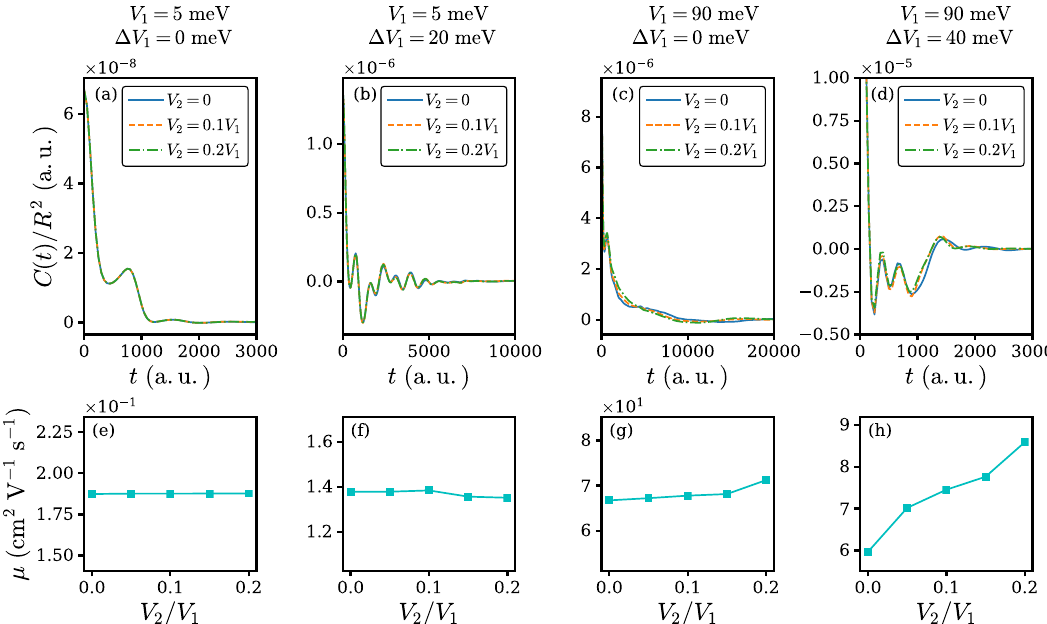
Fig. 6 The isotropy effect for several typical values of V 1 and Δ V 1 . a – d are the correlation functions C ( t ) and e – h are the corresponding mobilities μ . For a and e , V 1 = 5 meV and Δ V 1 = 0 meV; For b and f , V 1 = 5 meV and Δ V 1 = 20 meV; For c and g , V 1 = 90 meV and Δ V 1 = 0 meV; For d and h , V 1 = 90 meV and Δ V 1 = 40 meV.